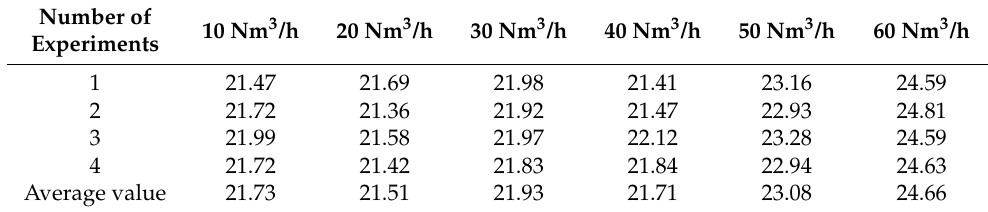
Table 11. Liquid particle size in Case 3 at M 1 ( µ